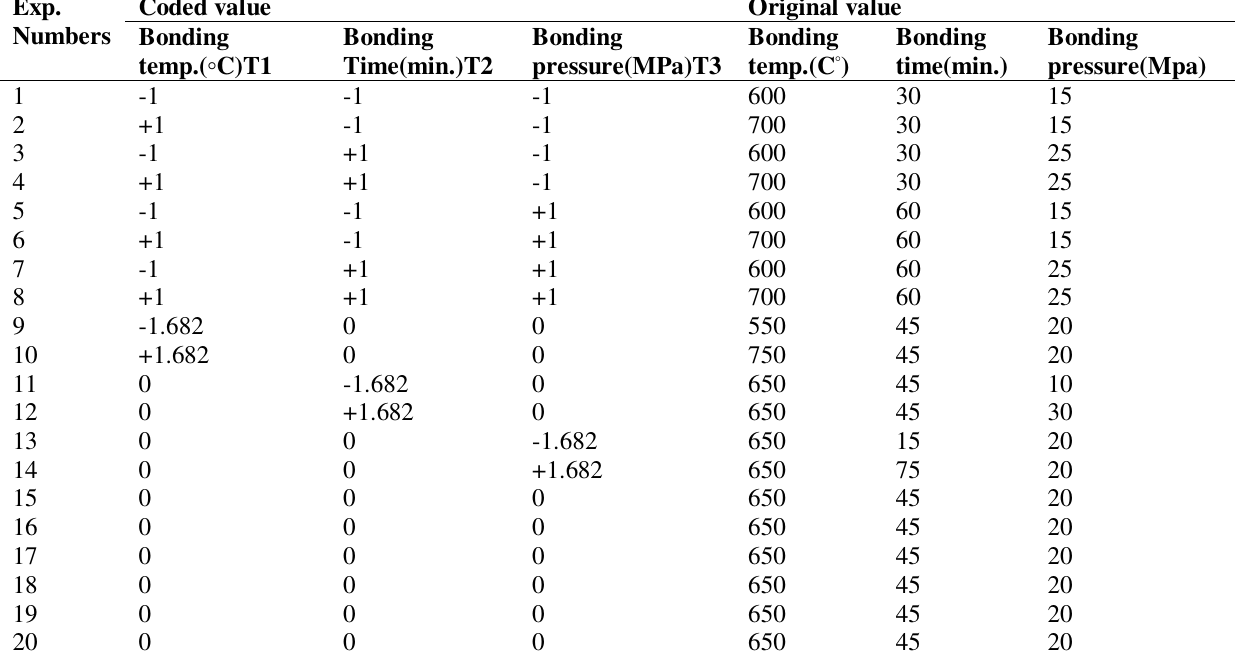
Experimental Design Matrix.